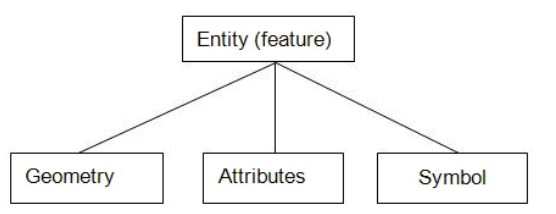
Figure 1: The structure of entity